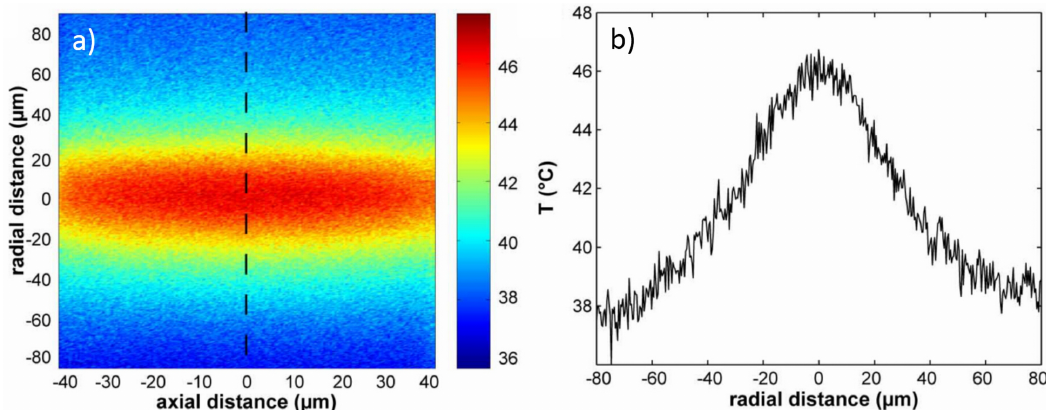
Figure 19. Spatial temperature profile in an optical stretcher. ( a ) Color image of the temperature increase from the two opposing laser beams in the optical stretcher. The imaging plane is the channel cross section through the center of the trap and the power of each laser beam is 1 W; ( b ) Line scan of the temperature along the dashed line in ( a ). Figure reproduced from Reference [71] with permission from Optical Society of America.